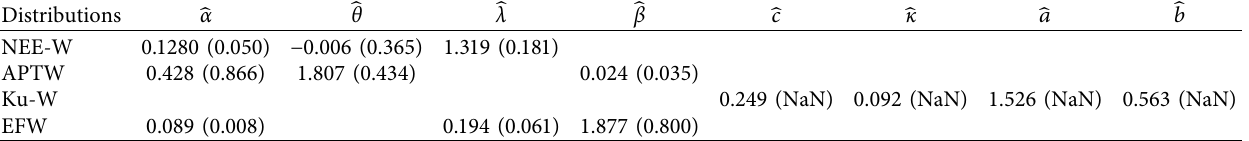
Table 5: Providing the numerical estimates and standard errors for the proposed and four compared models. Distributions